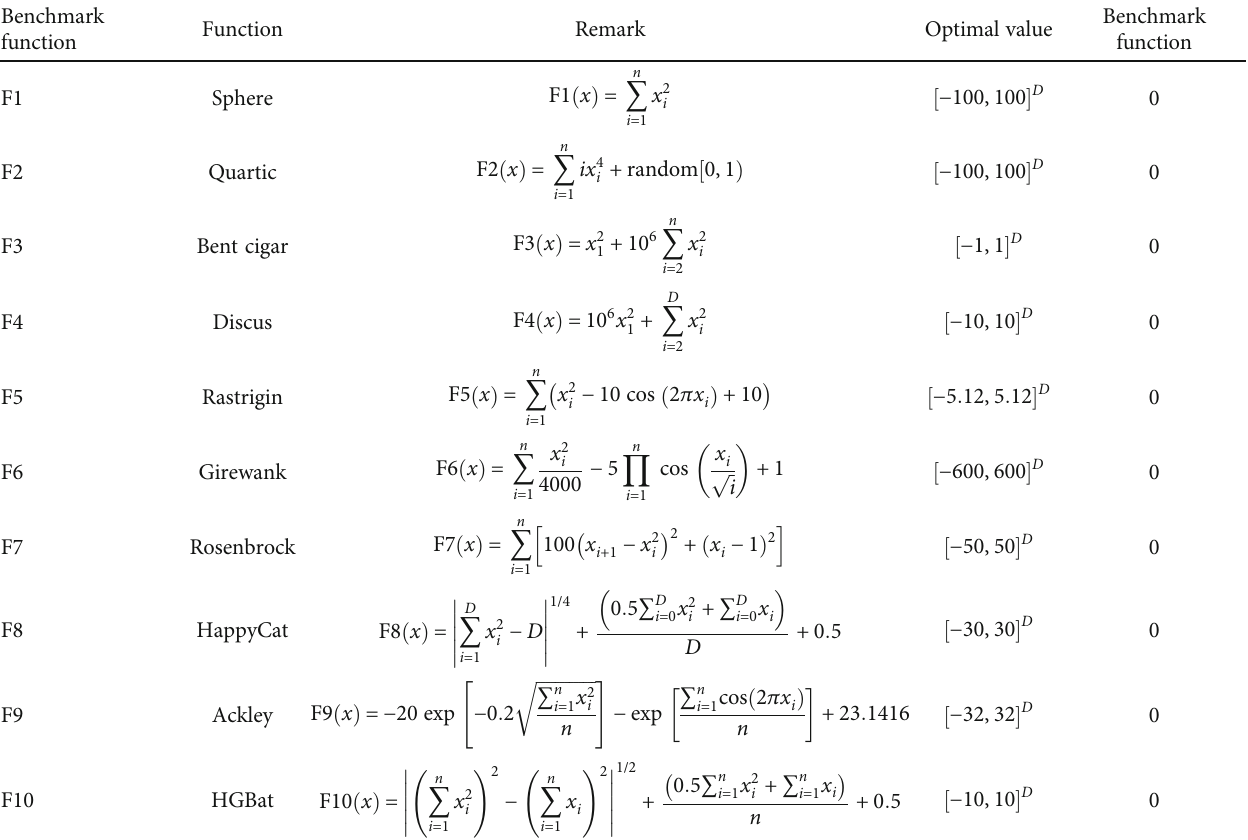
Table 1: Benchmark